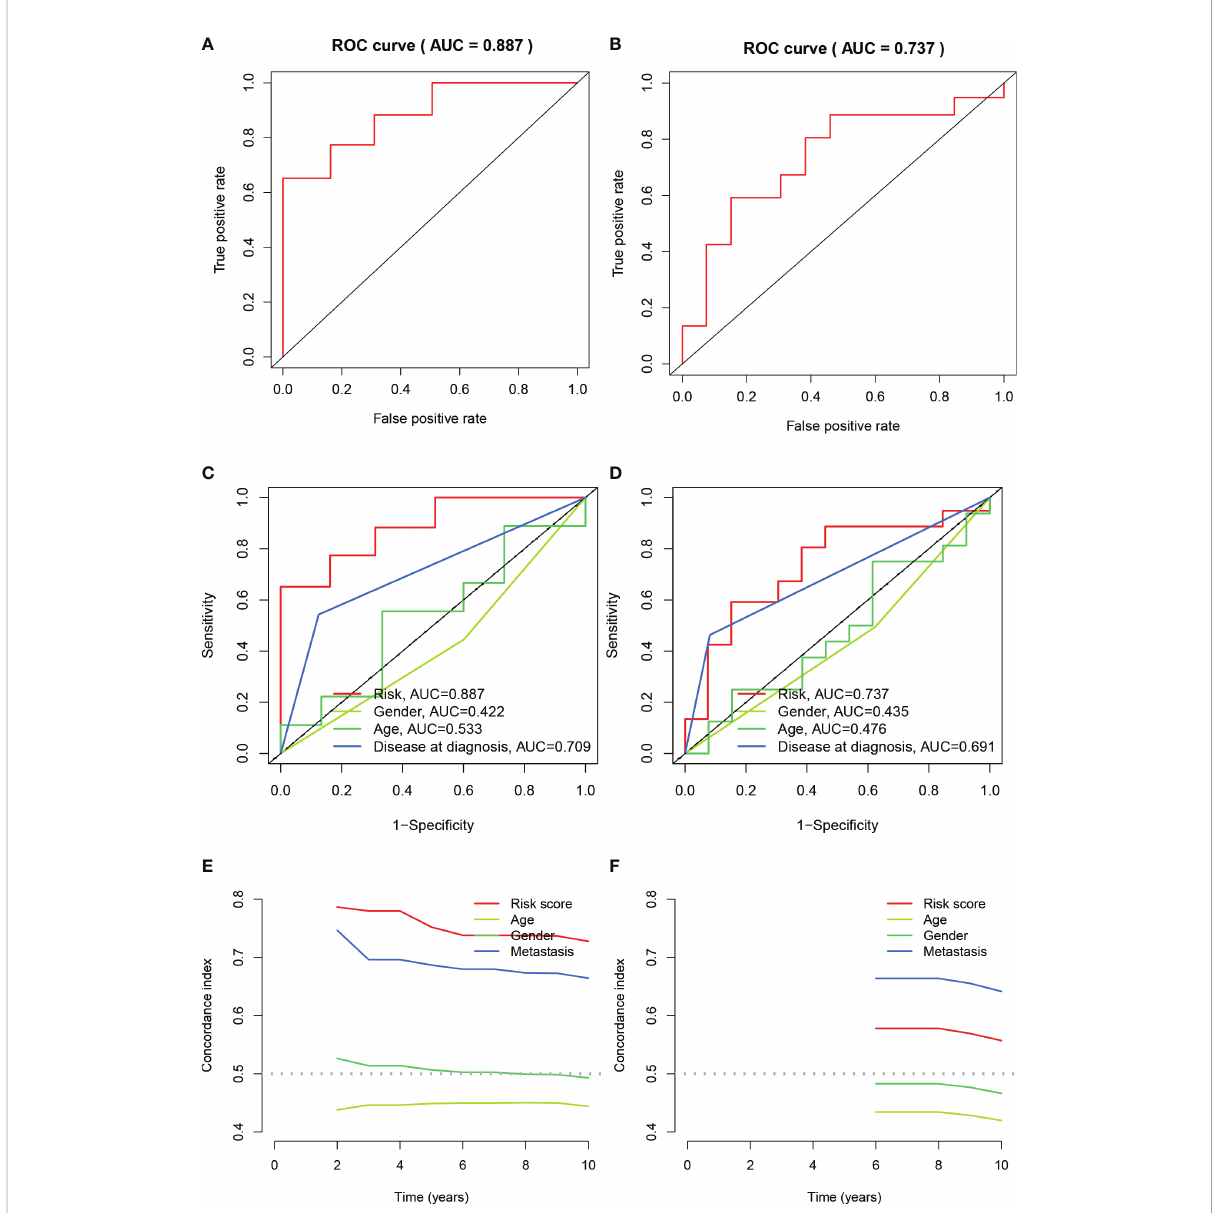
FIGURE 5 Assessing the accuracy of risk prognostic models. (A, B) The AUCs of 5-year survival ROC in the train and validation cohorts were 0.887 and 0.737. (C, D) The 5-year ROC curve combined with clinical characteristics re fl ects the better predictive value of risk score. (E, F) C-index index curves for the train and validation